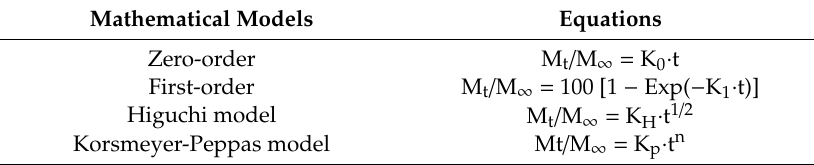
Table 2. Equations of mathematical models commonly used to describe mechanisms of drug release, where Mt / M ∞ is the fraction (%) of drug released after time t, K 0 , K 1 , K H , K P are drug release rate constants for the corresponding models and n is release exponent, indicating the mechanism of transport of drug.